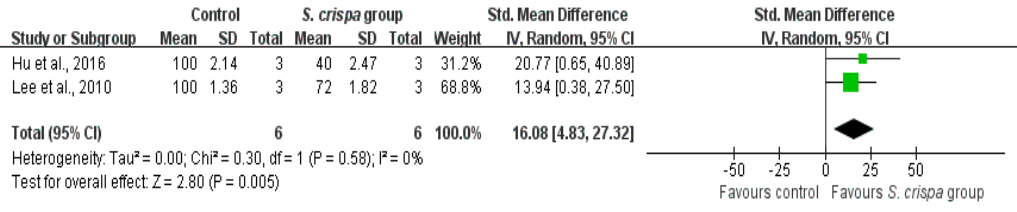
Figure 13. Sensitivity analysis of survival of cancer cell in cancer treatment between control and S. crispa groups. ( ): SMD of individual studies; ( ): summary SMDs of the comparison.